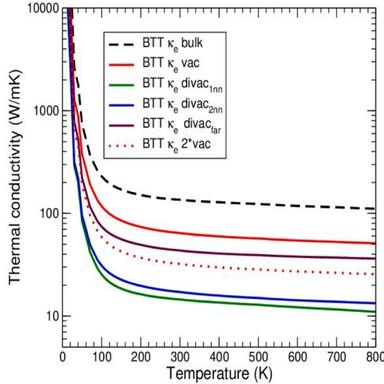
Thermal conductivity of tungsten computed as a function of temperature for two values of vacancy content. Bulk thermal conductivity, plotted as a function of temperature, is included as a reference. Calculations were performed using a 128-atom cell, and hence the single vacancy curve (red) corresponds to the vacancy content of 0.7%, whereas the divacancy curve corresponds to 1.4% vacancies per lattice site. These concentrations of defects are high (this stems from the limitations on the size of the simulat